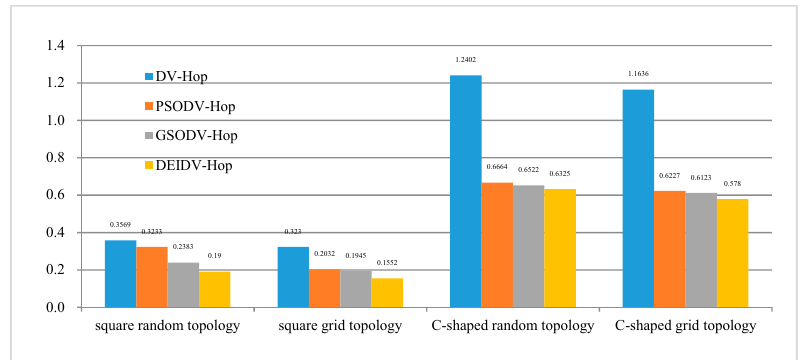
Figure 9. The average value of ALE for four topologies and algorithm.